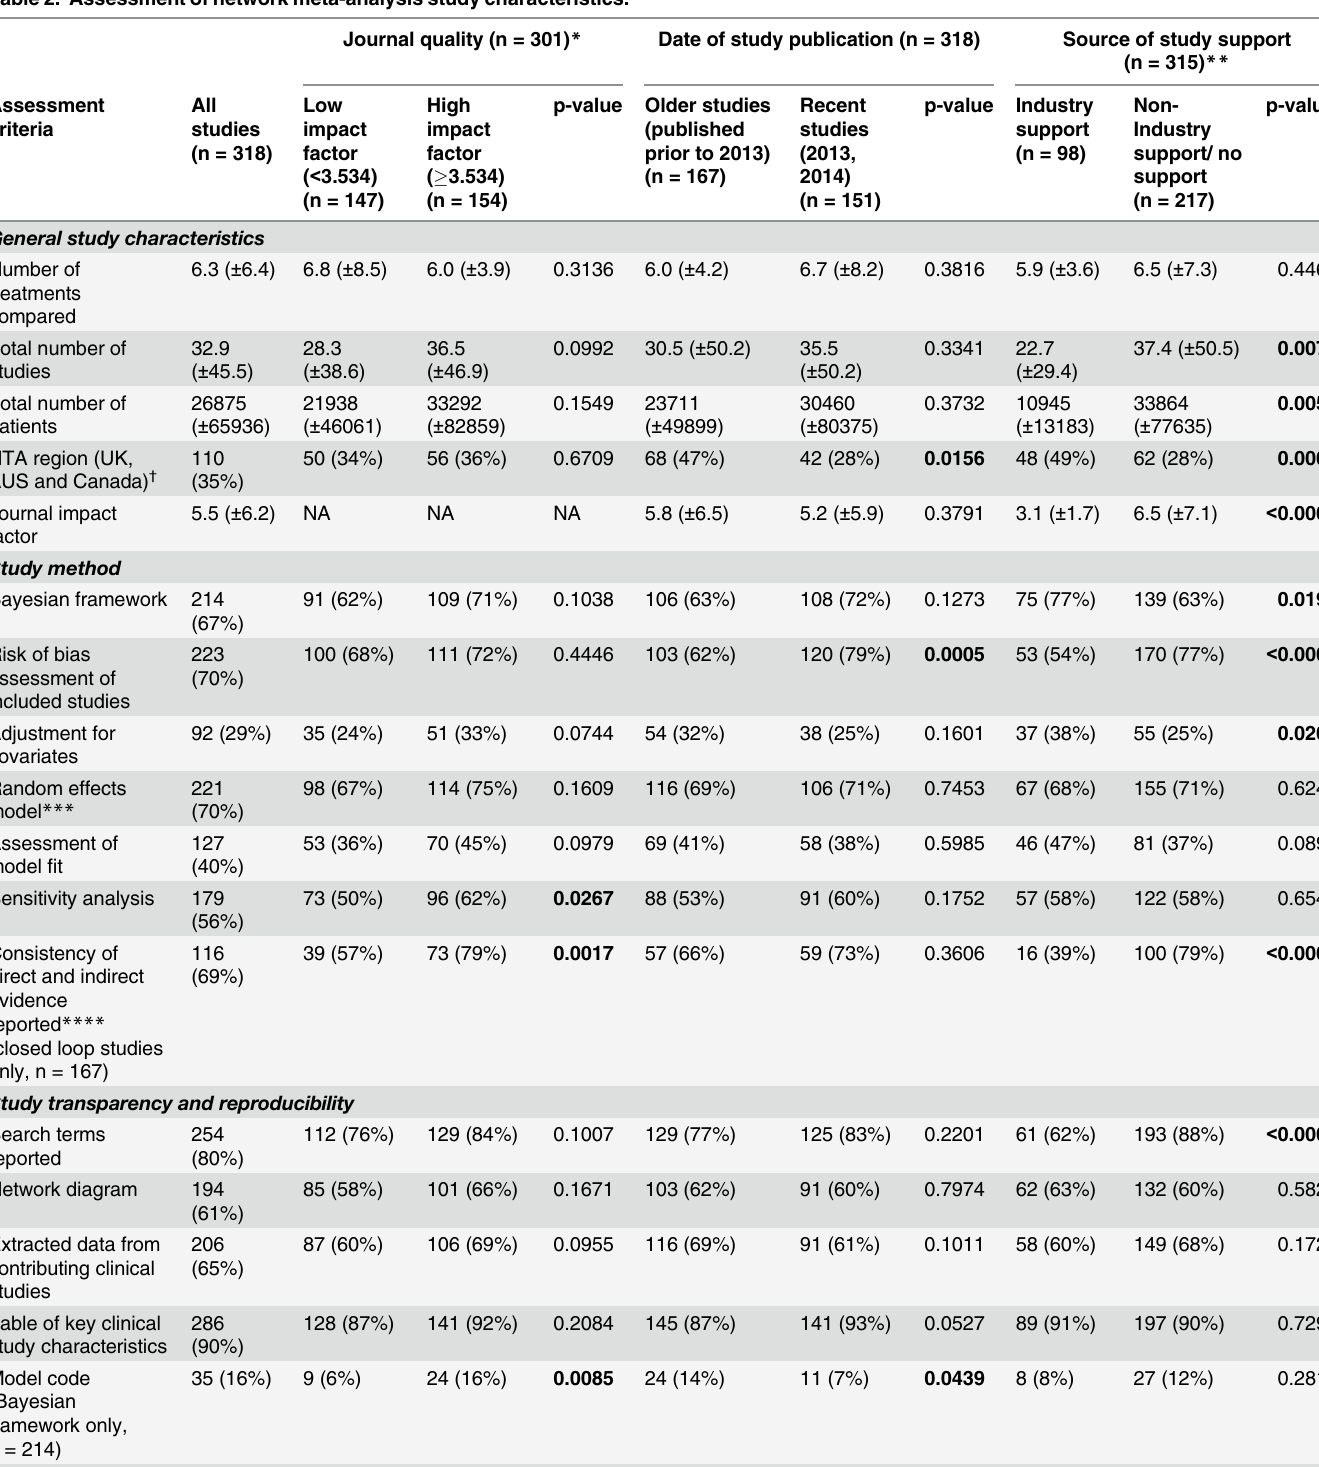
Table 2. Assessment of network meta-analysis study characteristics.